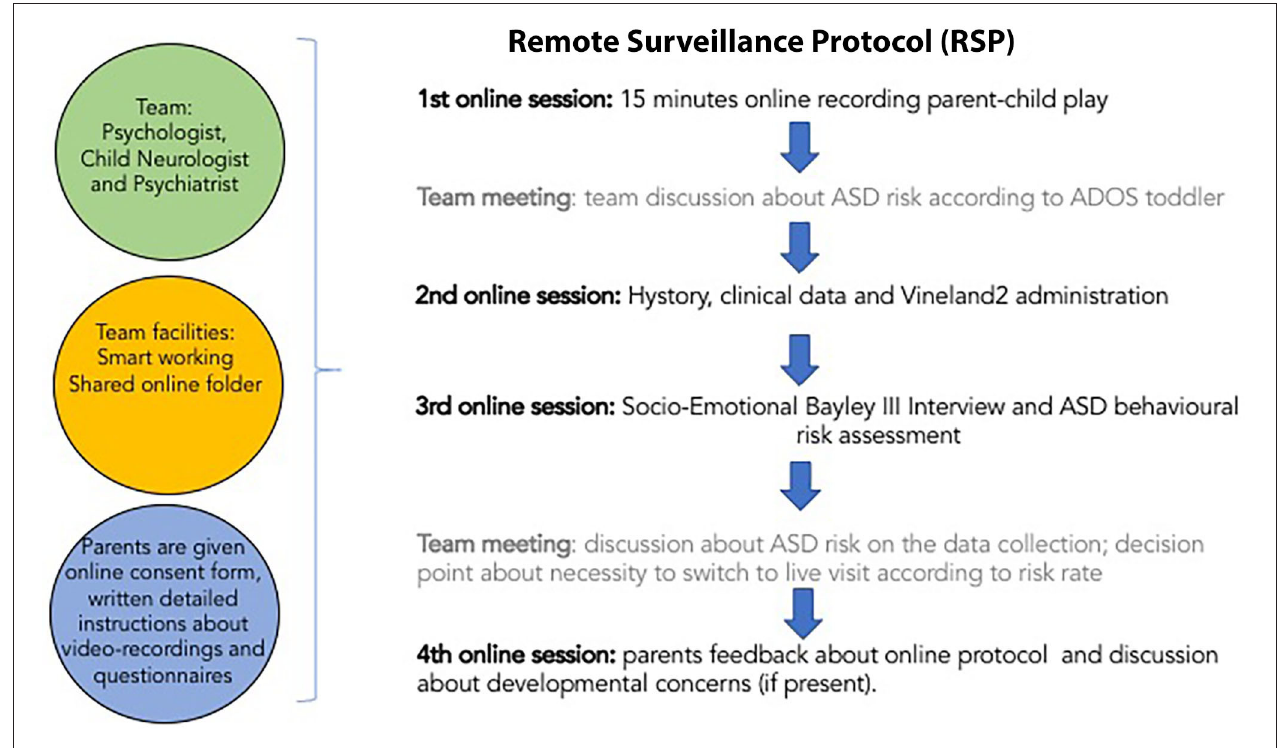
FIGURE 1 | Schematic representation of the remote surveillance protocol